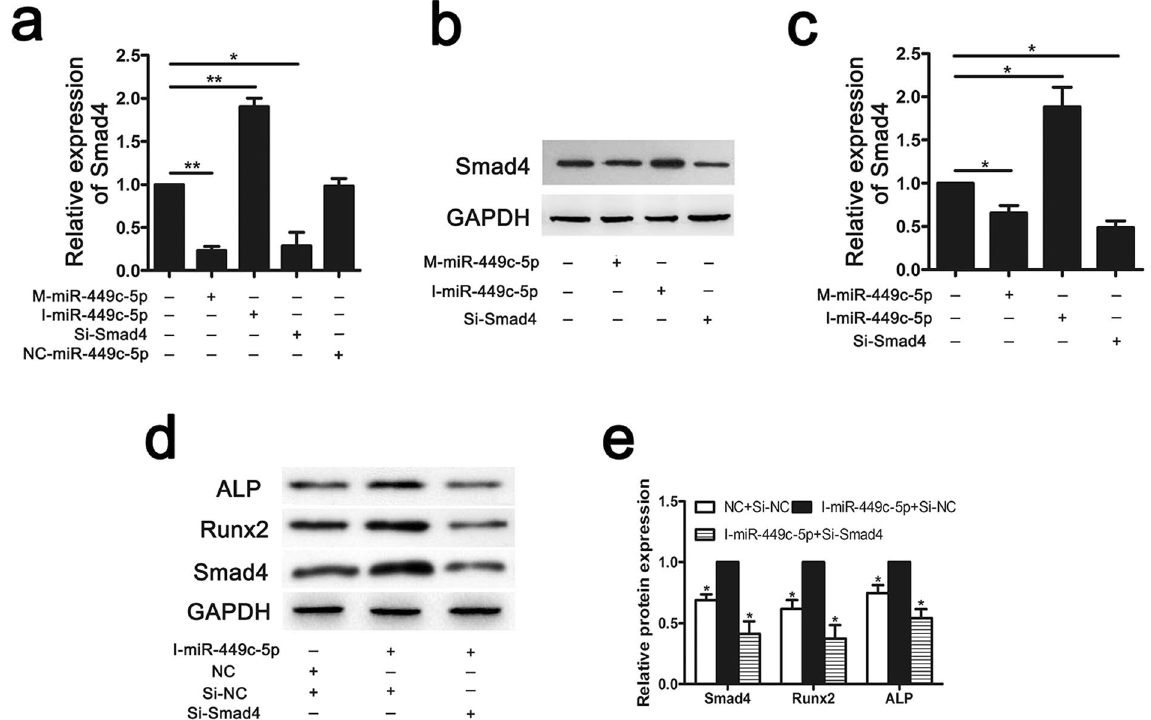
Figure 5. Regulation of Smad4 by miR-449c-5p during VICs osteogenic differentiation. ( a ) qRT-PCR analysis of Smad4 relative mRNA expression at day 7 after osteogenic differentiation. ( b , c ) Western blot analysis of Smad4 at day 14 after osteogenic differentiation. ( d , e ) Western blot further confirmed Smad4 knockdown could block the effect of miR-449c-5p inhibitor during VICs osteogenic differentiation. n = 3 in each group. Data are presented as the mean ± SD. * P < 0.05, ** P <